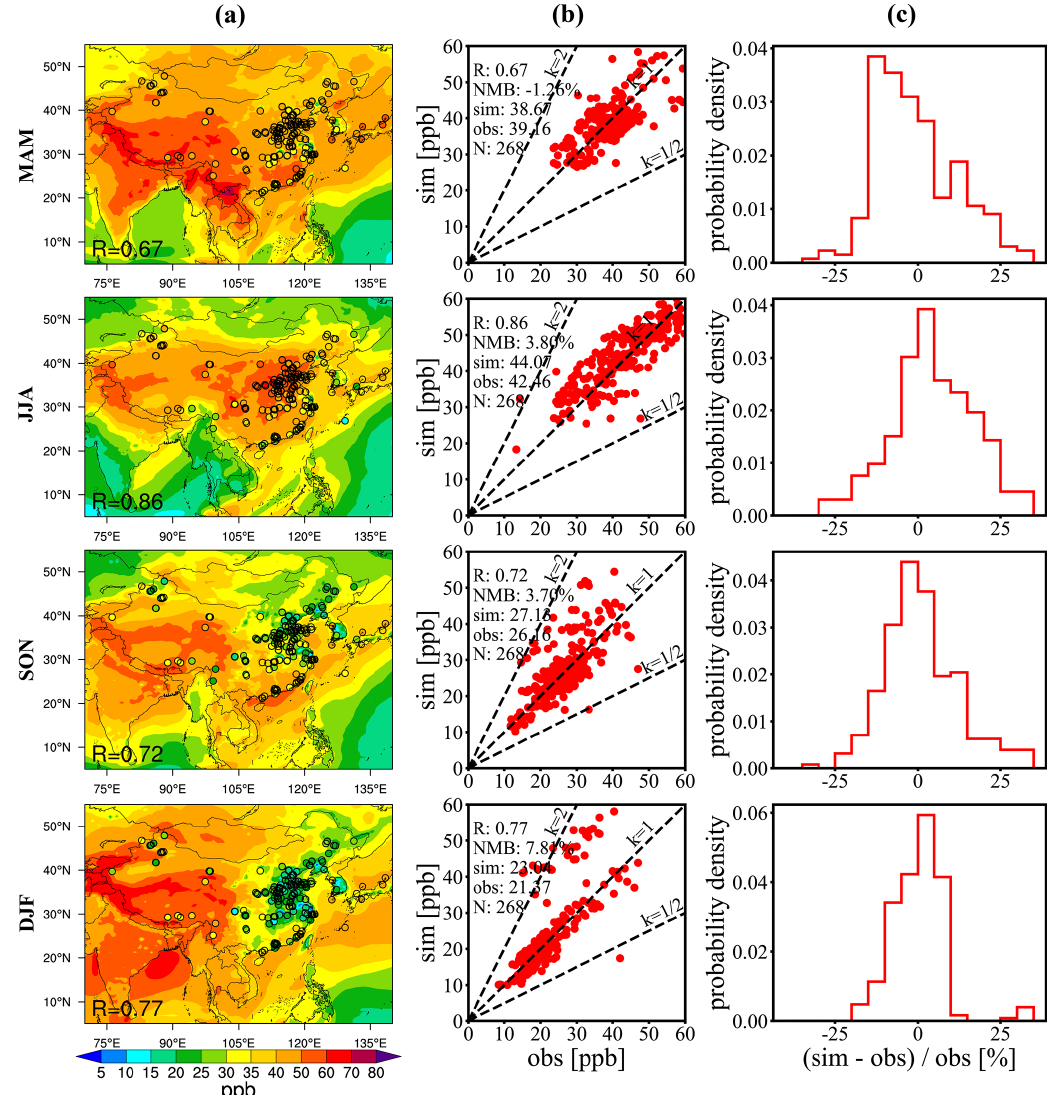
Figure 7. Comparison of surface O 3 in East Asia. (a) Spatial distribution of simulated (shaded) surface O 3 concentrations compared with observations (solid circles). (b) Scatterplots of simulated (sim) and observed (obs) seasonal mean O 3 . The black dotted lines are the 2 : 1, 1 : 1, and 1 : 2 reference lines from left to right. (c) The probability density functions of